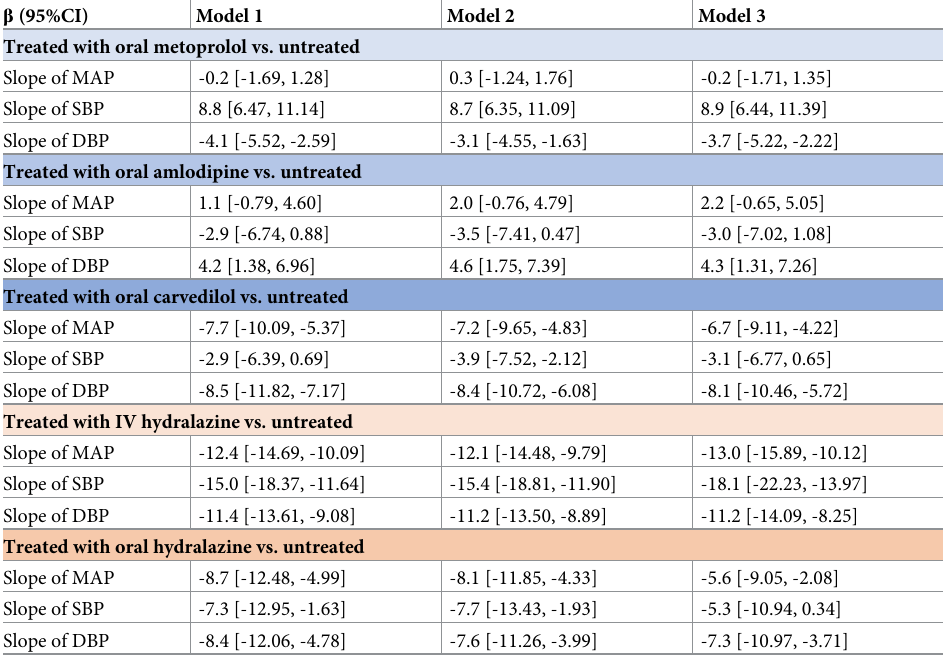
Table 2. Association of the most common antihypertensives given for treatment of severe inpatient hypertension with blood pressure. β